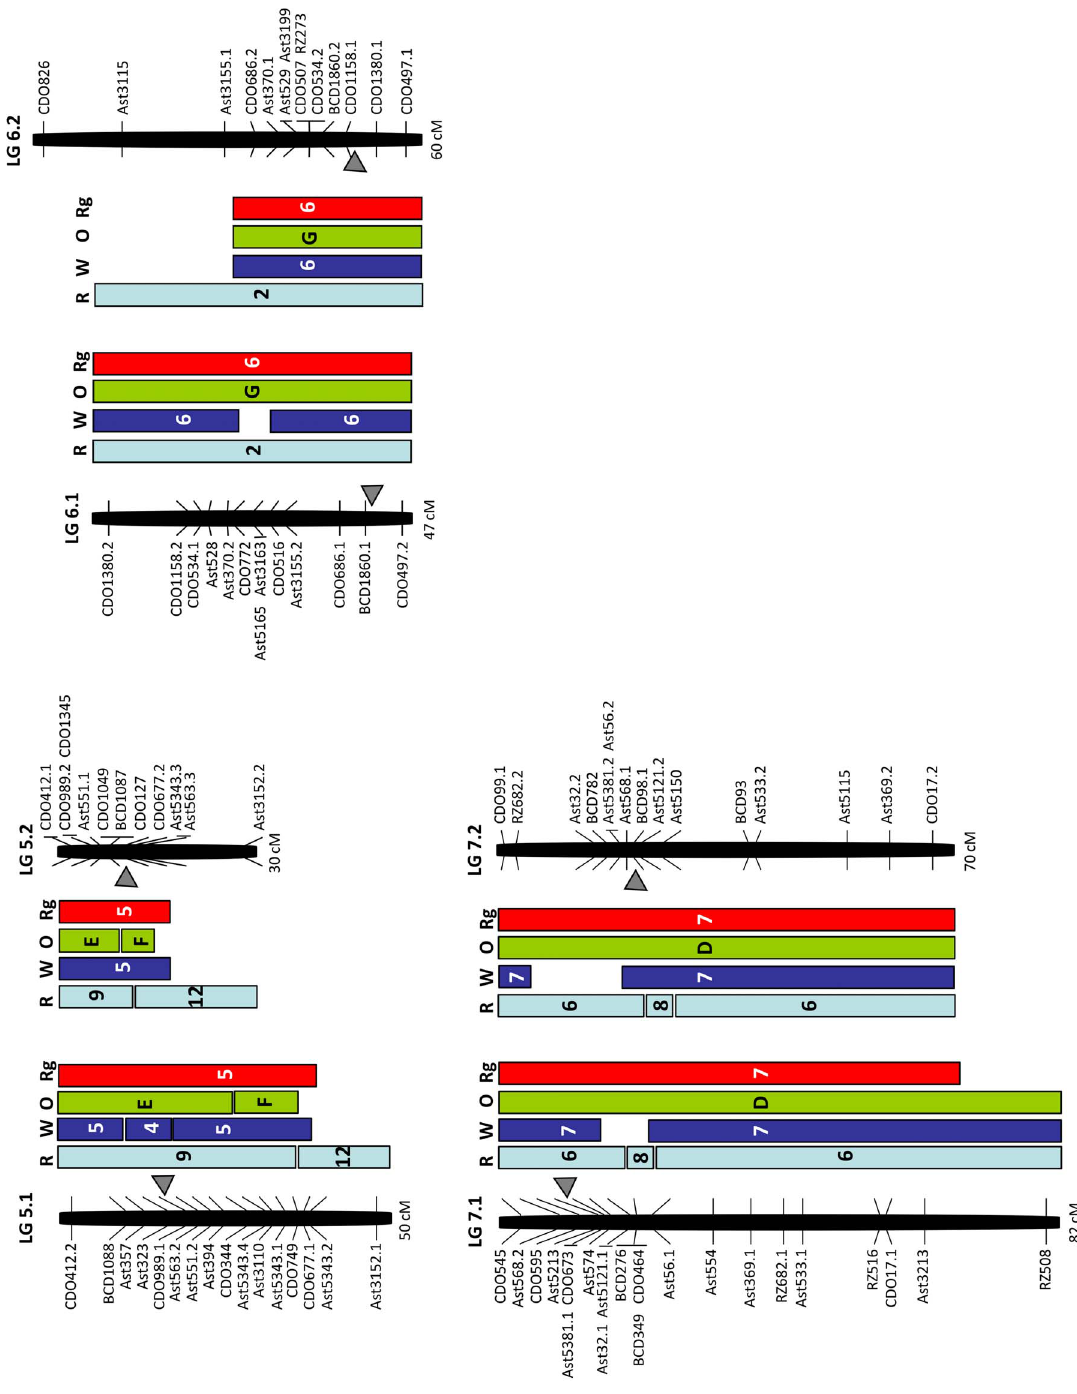
Figure 3. Comparative genome relationships on creeping bentgrass linkage groups 5 – 7 relative to rice, the Triticeae, oat, and ryegrass. Comparative genome relationships between creeping bentgrass genetic linkage map and the genetic maps of rice (R), the Triticeae (W), oat (O), and ryegrass (Rg), respectively, represented by a colored box. The markers shown on the right or left side of each linkage group correspond to those mapped in the creeping bentgrass linkage map shown in Figure 1. The number or letter inside the color boxes represents the segments of chromosomes or linkage groups from each of the genomes (R, W, O, Rg) that are syntenic to the bentgrass linkage groups. The arrowheads indicate the deduced location of the centromere in bentgrass from the comparisons with Triticeae chromosomes. The total map distances (cM) are shown on the bottom of each linkage group.